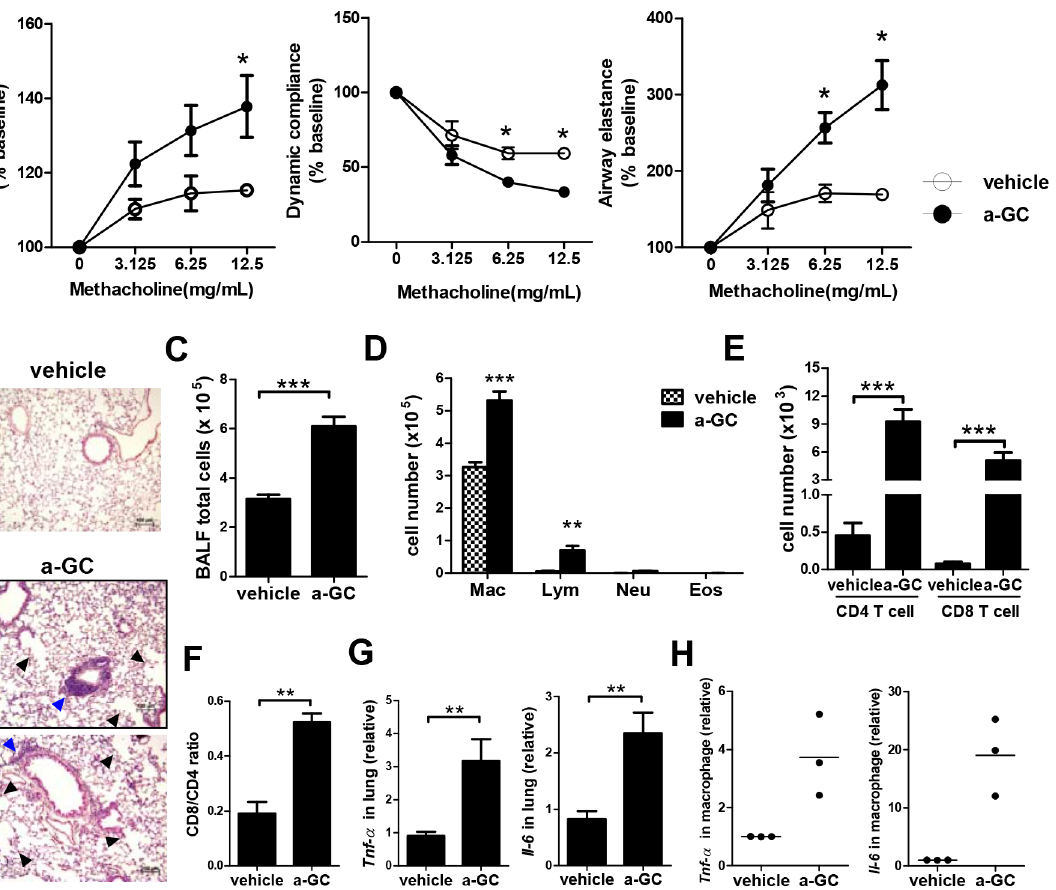
Fig 3. Increased airway inflammation in mice repeatedly administered with α -GalCer. Mice received intranasal α -GalCer administration once a week for 6 weeks and airway inflammation was measured 2 weeks after the last administration. (A) Analysis of lung function. Changes in airway resistance, dynamic compliance, and airway elastance were measured on mechanically ventilated mice, in response to increasing doses of methacholine. (B) Representative results of H-E examination of lung sections (x100 magnification). Blue arrowheads indicate cell infiltration in the lung. Black arrowheads indicate airspace enlargement in the lung. (C) The total numbers of cells present in BALF. (D) The absolute numbers of macrophages, lymphocytes, neutrophils, and eosinophils, present in BALF. Mac, macrophage; Lym, lymphocyte; Neu, neutrophil; Eos, eosinophil. (E) The absolute numbers of CD4 + and CD8 + T cells were examined. (F) CD8/CD4 ratios of T cells were measured. (G) Lung tissues were isolated and the expression of TNF- α and IL-6 was detected by quantitative RT-PCR. n = 9 – 14 mice for each group. (H) Macrophages from BALF were isolated and their expression of TNF- α and IL-6 was detected by quantitative RT-PCR. Individual symbols represent a sample pooled from 3 – 5 mice and the horizontal lines represent the mean values. a-GC, α -GalCer. * , p < 0.05; ** , p < 0.01; *** , p < 0.001 using Mann-Whitney U